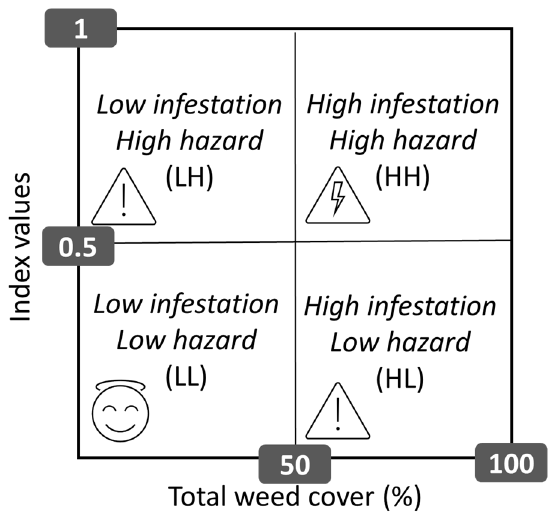
Figure 4. Example of a diagram describing the impact of weeds. The position of each index in the quadrants is given by its respective value (vertical side) and by the total cover (horizontal side). We assume “high or low” an index greater or less than 0.5, while we consider “high” an infestation cover greater than 50%. Covers > 100% are assumed to be equal to